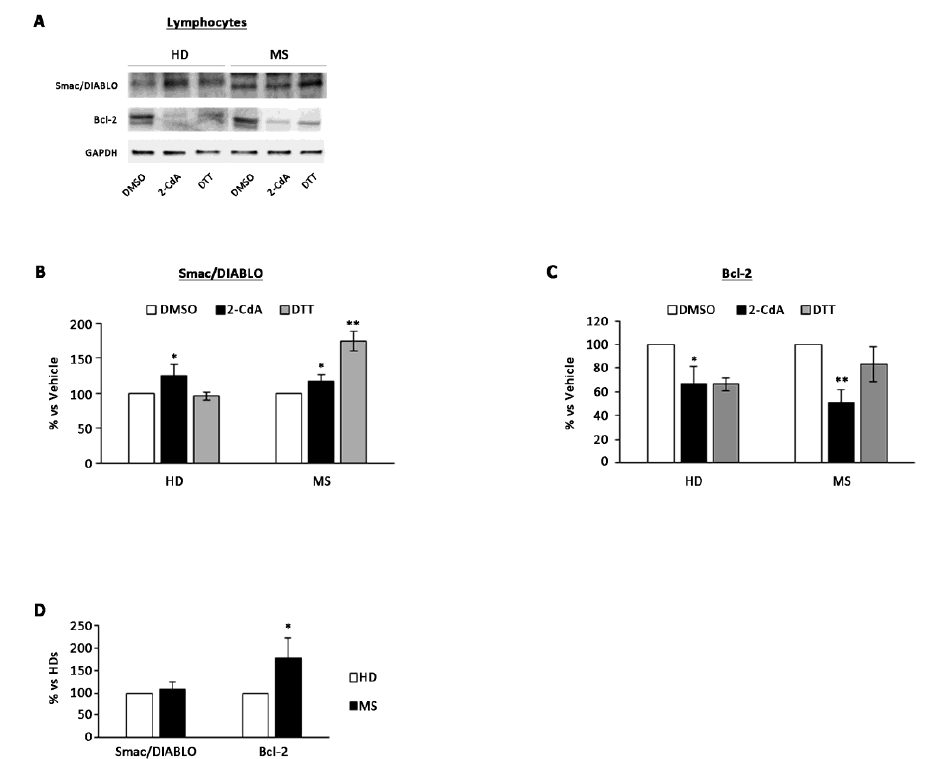
Figure 1. E ff ect of 2-CdA treatment on Smac / DIABLO and Bcl-2 protein expression in HDs and multiple sclerosis (MS) lymphocytes. ( A ) Representative Western blot of Smac / DIABLO and Bcl-2 levels performed on whole cell lysates. Bar graphs show quantification by densitometric analysis of Smac / DIABLO ( B ) and Bcl-2 ( C ) protein band normalized to GAPDH, used as loading control. Values (mean ± SEM of three independent experiments) are expressed as percentage of dimethyl sulfoxide (DMSO). ( D ) Bar graph showing densitometric analysis of Smac / DIABLO and Bcl-2 protein levels in healthy donors (HD) and multiple sclerosis (MS) lymphocytes not exposed to cladribine (2-CdA). Significance was calculated with Student’s t-test; * p < 0.05, ** p < 0.005 vs. DMSO ( B , C ) or vs. HDs ( C ). DTT, dithiothreitol.